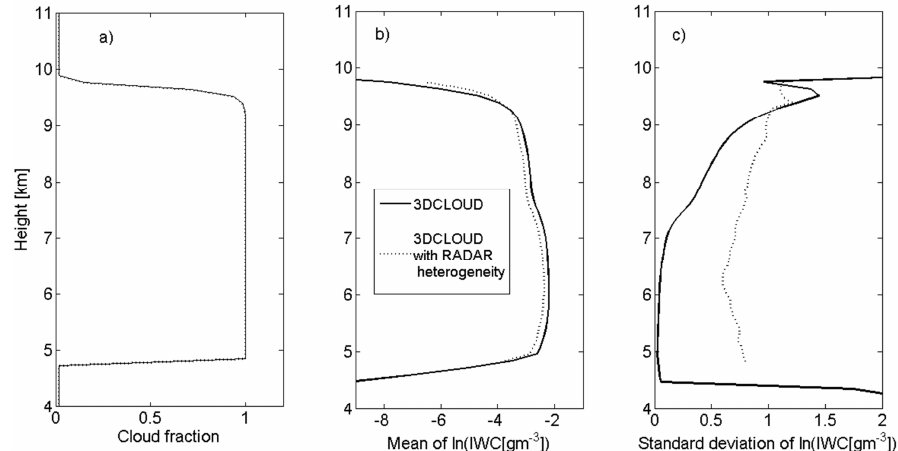
Figure 16. Vertical profiles for the RC99 case of (a) cloud fraction, (b) mean of ln(IWC) for the cloudy voxels and (c) standard deviation of ln(IWC) for cloudy voxels computed from two 3DCLOUD fields obtained at the second step of the algorithm. The solid lines indicate simulation where inhomogeneity parameter is ρ IWC = 0 . 4 and the dotted lines indicate simulation where the parameter ρ IWC , function of height, is derived from the 27 December 1999 RADAR measurements between 10:00 and 12:00UTC and crudely estimated from the Fig. 2c in Hogan and Kew (2005).